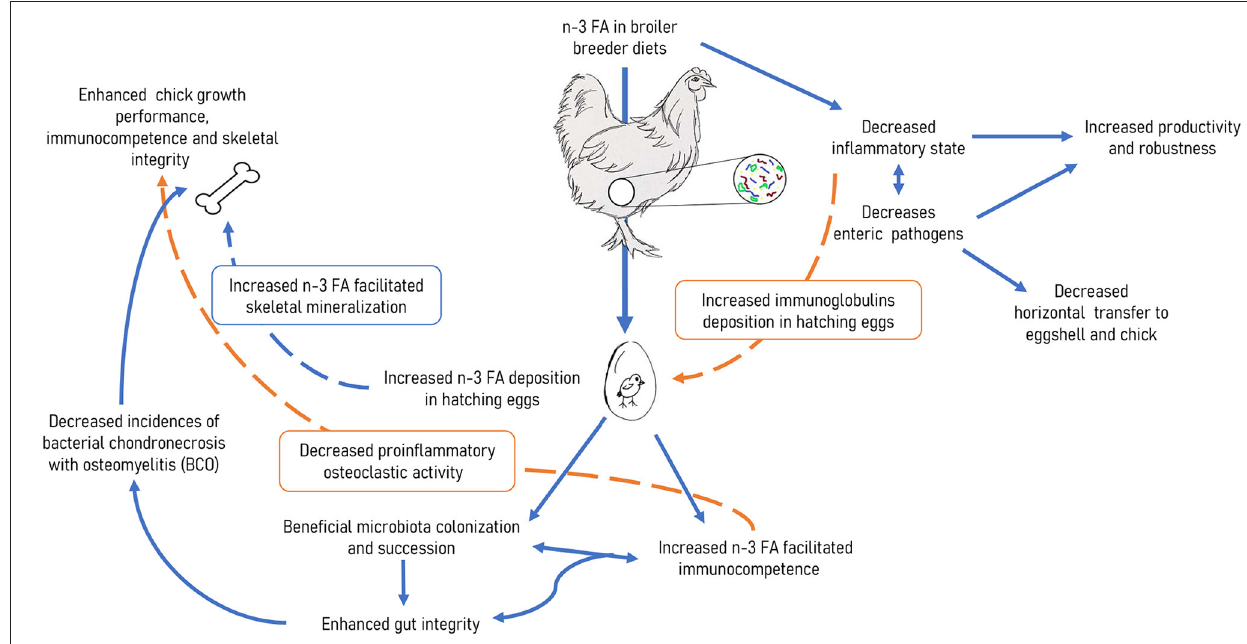
FIGURE 1 | Pathways for modulating immunocompetence, skeletal, and gastrointestinal attributes in broiler chickens hatched from broiler breeders fed omega-3 polyunsaturated fatty acids.